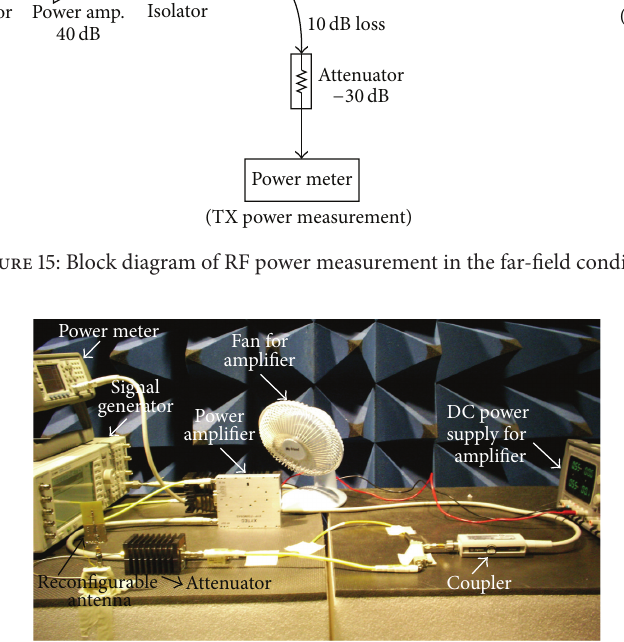
Signal generator